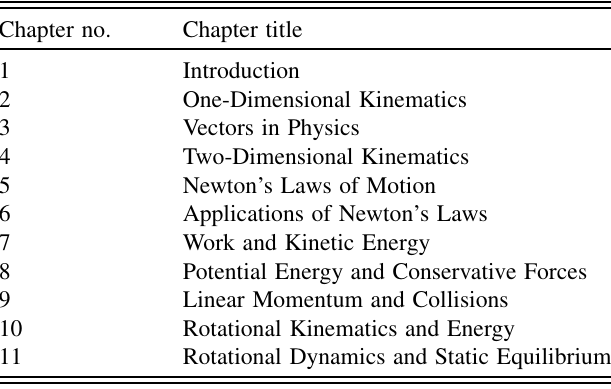
TABLE I. Chapter titles taken from Walker’s textbook as a representative